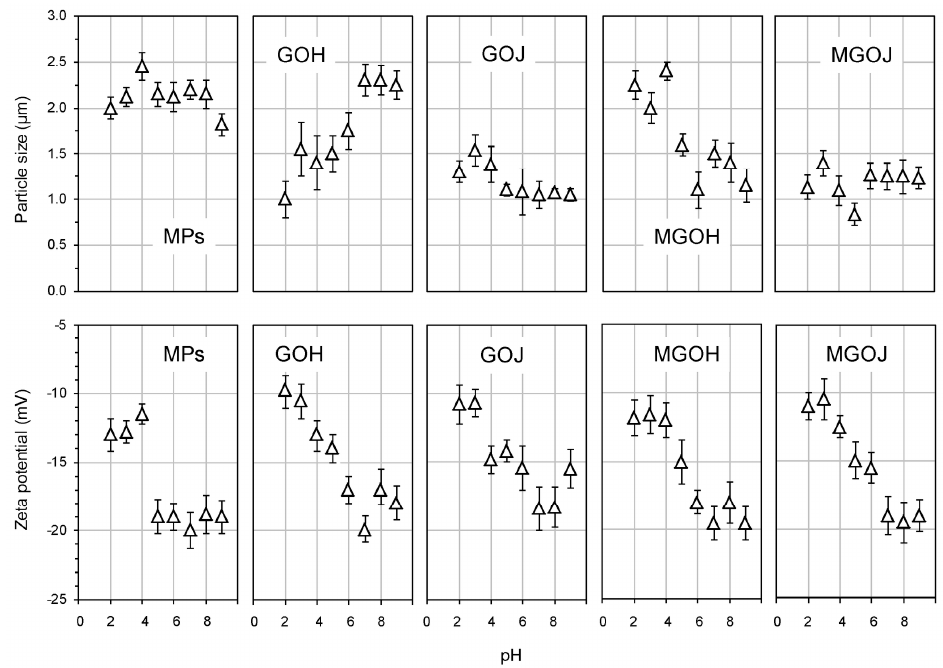
Figure 4. Comparison of the mean size and zeta potential of the individual materials employed in different pH values. Table 1. The natural pH values of the employed materials microparticles (MPs), large area graphene oxide (GOH), small area graphene oxide (GOJ), large area graphene oxide modified by iron oxide based microparticles (MGOH), and small area graphene oxide modified by iron oxide based microparticles (MGOJ). Material Natural pH MPs